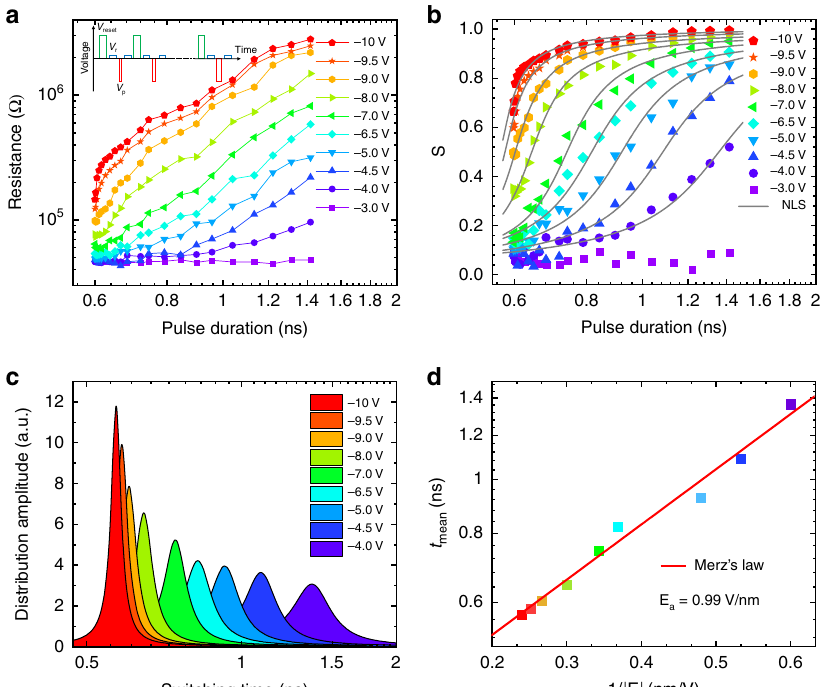
Fig. 3 Ferroelectric domain switching dynamics. a Resistances measured at 0.1 V and b relative area fraction of the ferroelectric up domain versus pulse duration. Inset of a illustrates the applied voltage pulse sequence. Solid curves in b are the fi tting results by the NLS model. c Lorentzian distributions of switching time extracted from the fi ts in b at different pulse amplitudes. d Evolution of the mean switching time ( t mean ) as a function of the inverse of the electric fi eld (1/ |E |). The solid line is the fi tting result by Merz ’ s